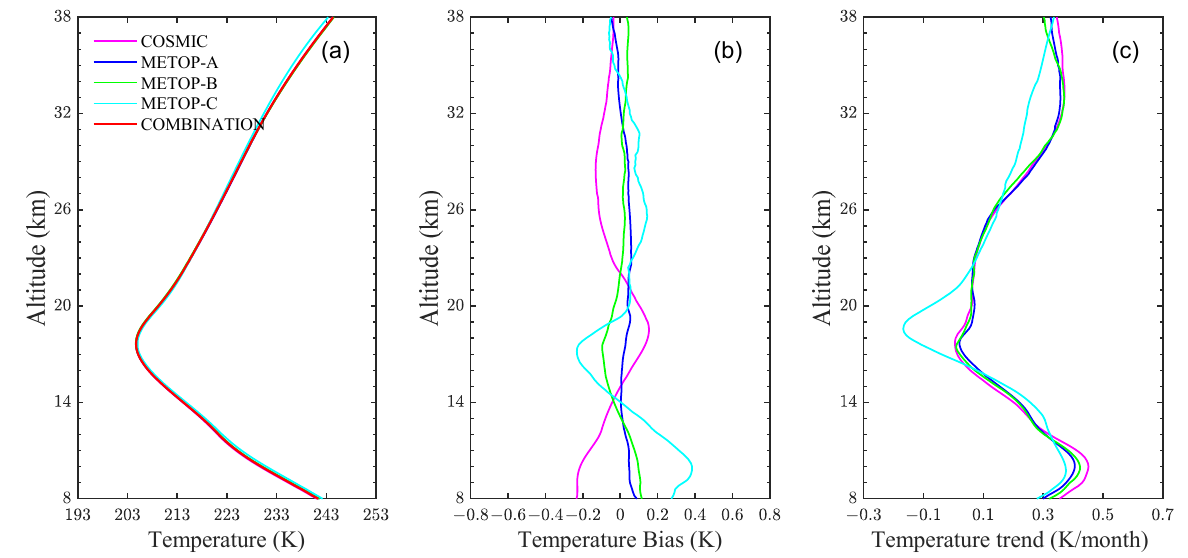
Figure 5. The ( a ) temperature, ( b ) temperature bias, and ( c ) temperature trend in each RO mission varying with altitude at 8~38 km. Magenta solid line, the COSMIC temperature; blue solid line, the METOP-A temperature; green solid line, the METOP-B temperature; cyan solid line, the METOP-C temperature; red solid line, the combined temperature.